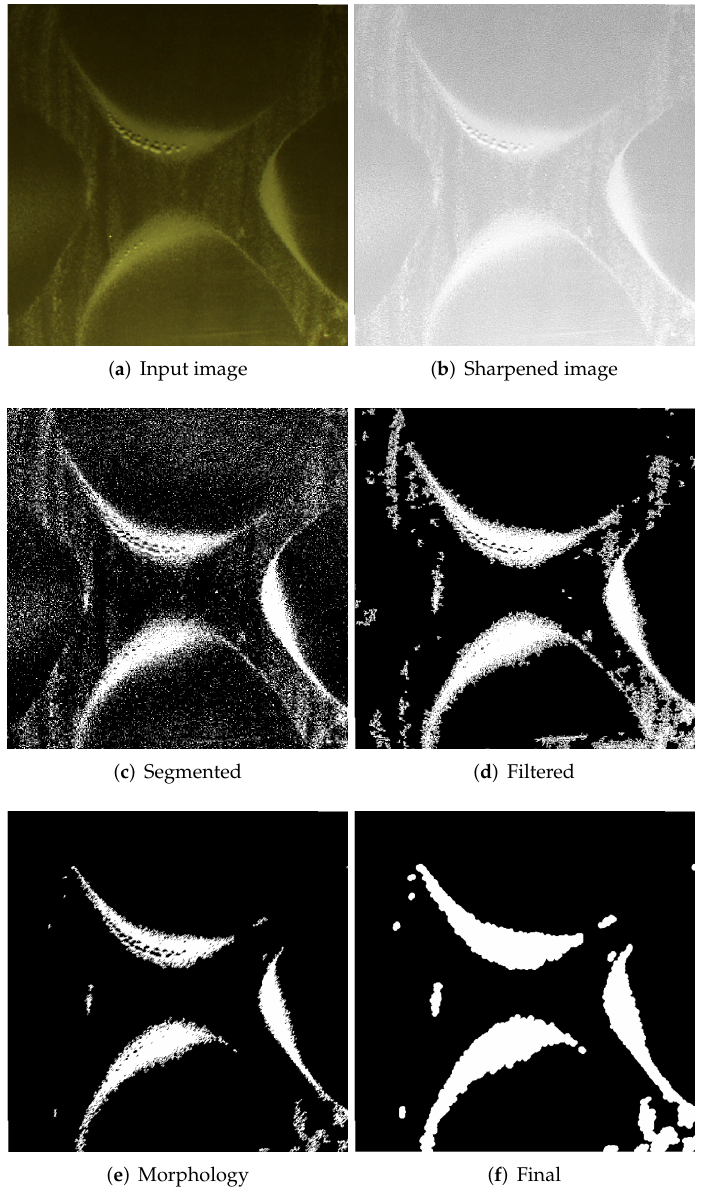
Figure 12. Samples of a mode shape at different stages of